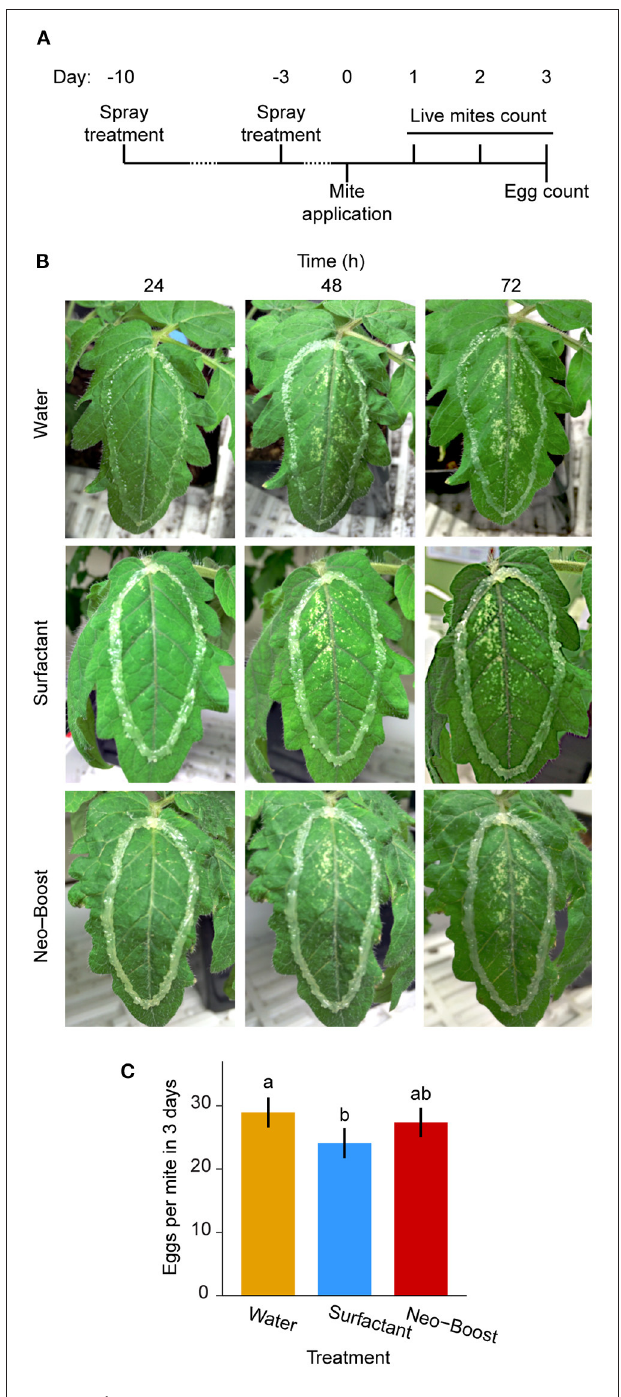
FIGURE 4 | Contact and residual effects of Neo-Boost formulations on larvae. (A, B) Residual effect of neo-boost formulations on larval mortality 48 hours post-treatment (A, n = 60/treatment) and developmental progression [B, n = 29–60/treatment, depending on number of samples with surviving mites from (A)]. (C) Contact effect of neo-boost formulations on larval mortality 1-hour post-treatment (100 ≤ n ≤ 120/treatment). Shown are proportions of dead mites/developmental stages ± 95% confidence interval (CI). Letters within graphs represent differences between pairwise comparisons of means by Tukey’s HSD ( P < 0.05).